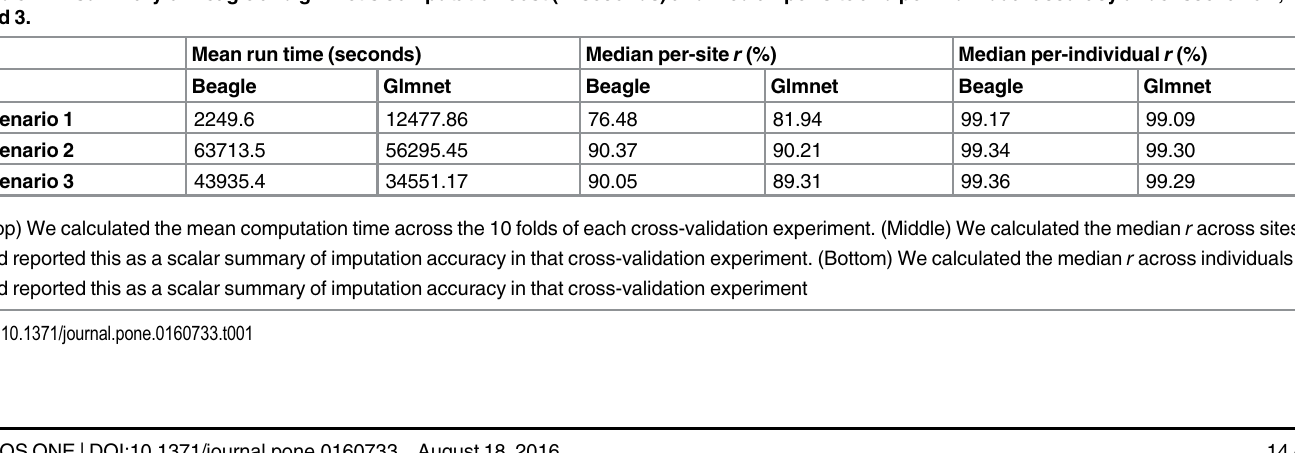
Fig 5. The accuracy difference between reference panel A and panel B as a function of MAF and proportion of missing data for 11535 sites. (A) Genotypes in a sample of 2490 C1 individuals were imputed using two different reference panels: reference panel A, comprised of 694 phased GG individuals, and reference panel B, comprised of 80 phased individuals listed as progenitors of the C1 population. (B and C) Points falling on the black vertical line at y = 0 indicate no observed accuracy difference when imputing with reference panel A or B. Points falling below y = 0 represent cases where Beagle imputes with higher accuracy when using reference panel B relative to imputing with reference panel A.